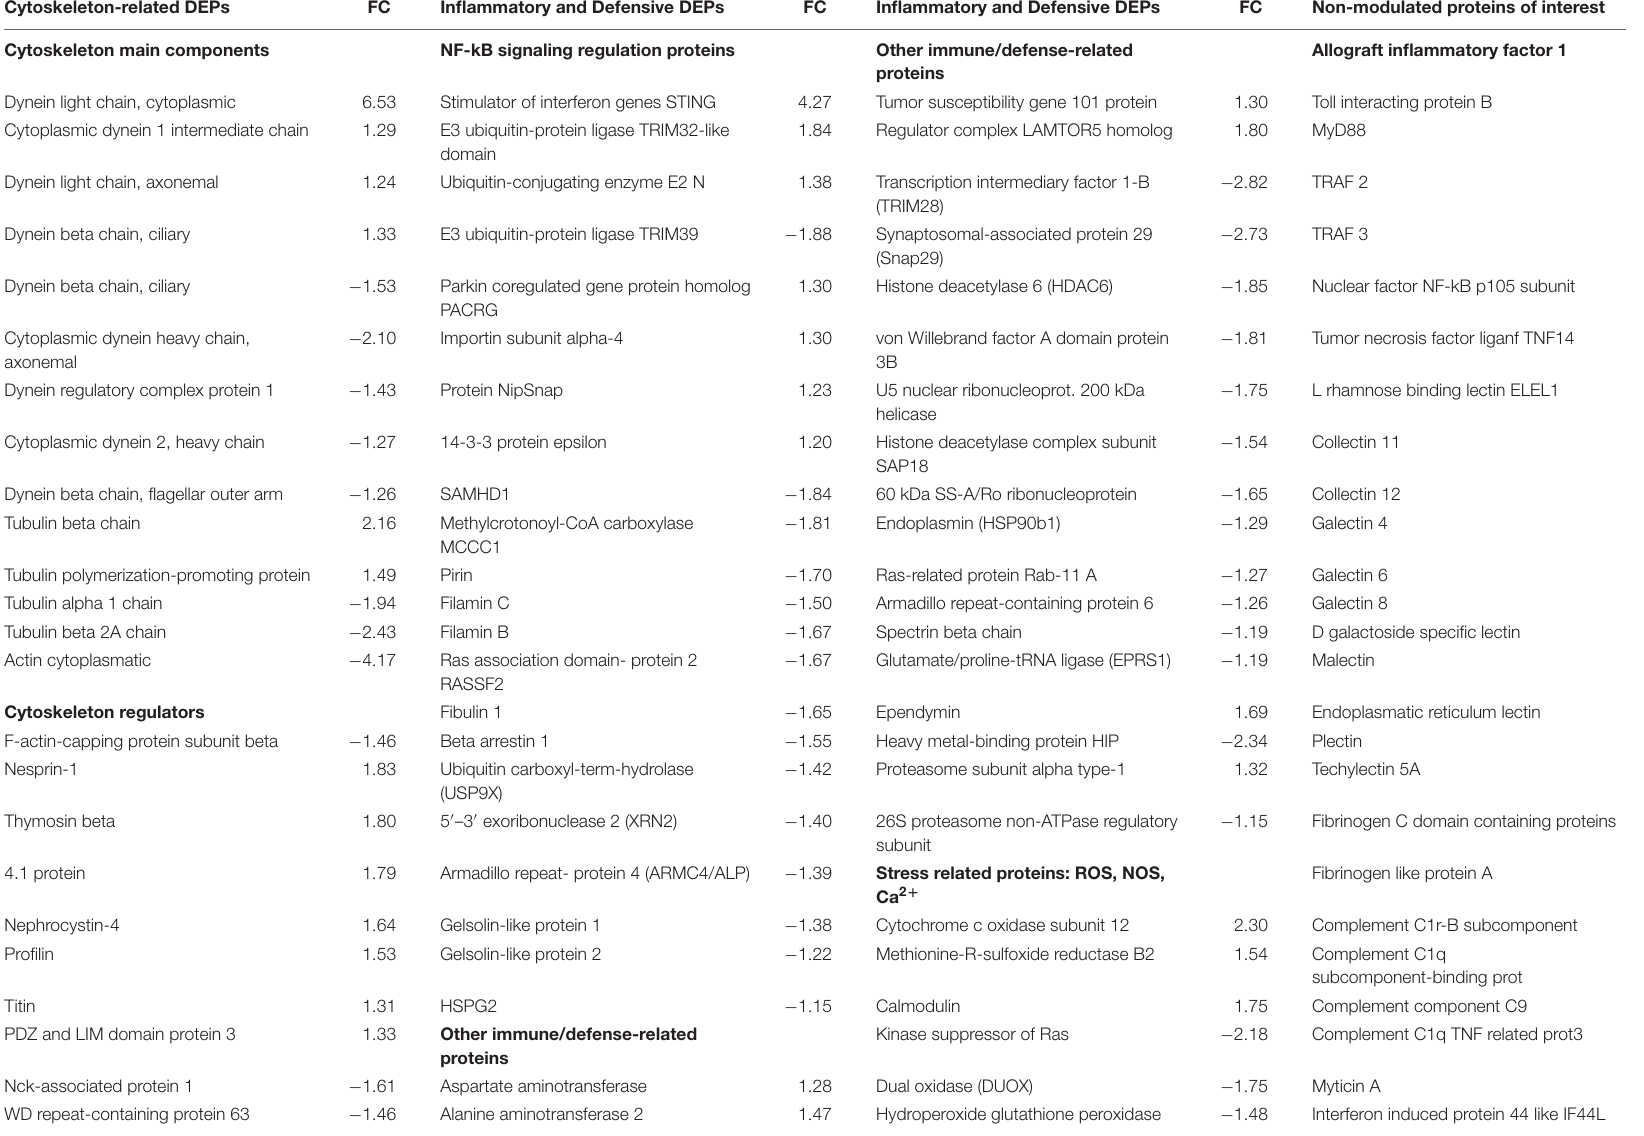
TABLE 2 | Differentially expressed proteins (DEPs, q -value < 0.05) and non-modulated proteins of interest. Cytoskeleton-related DEPs